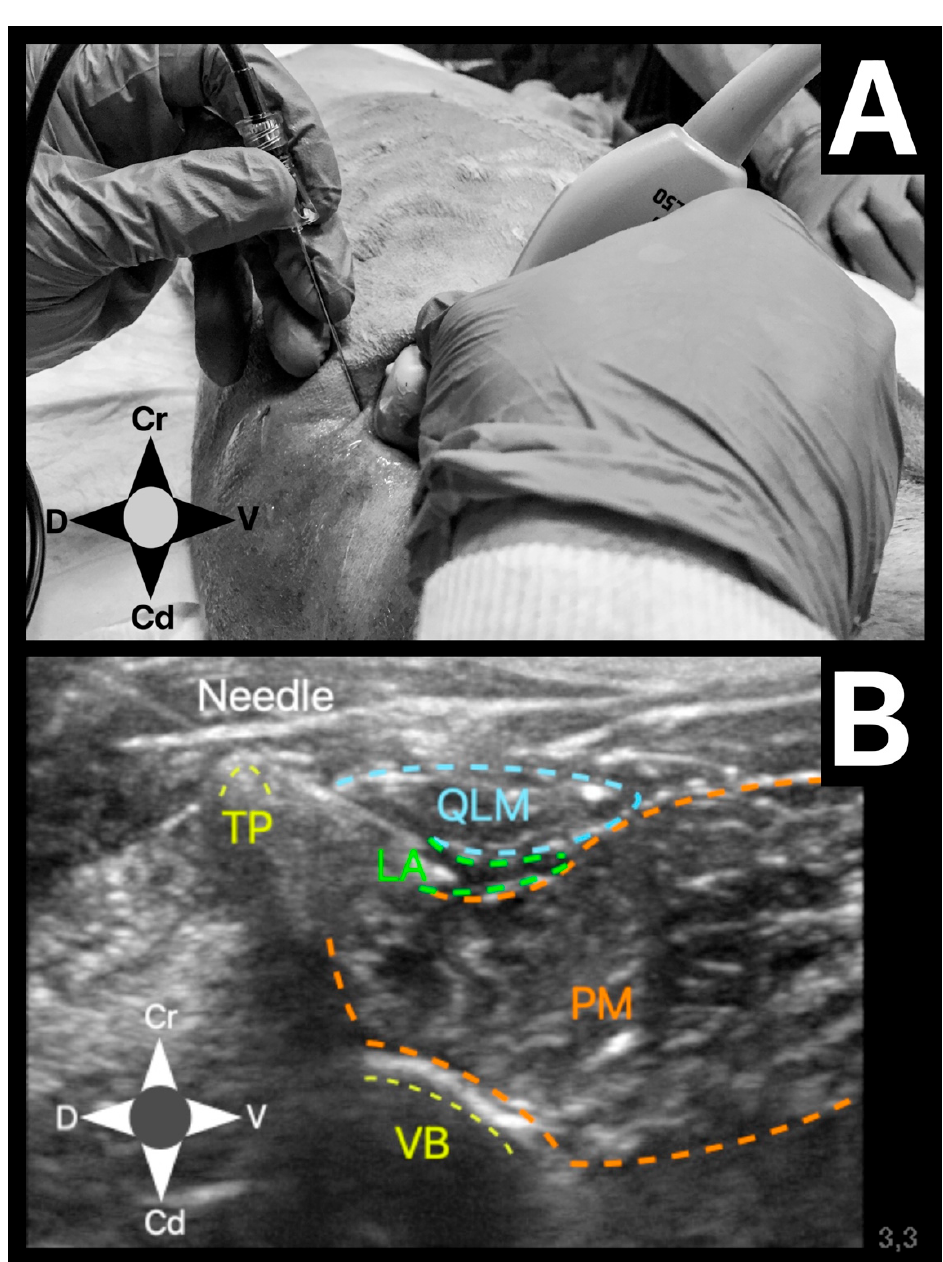
Figure 2. ( A ) Showing the positioning of the ultrasound probe and needle using the in-plane technique. The ultrasound probe was positioned in the lateral aspect of the lumbar muscles, caudal to the last rib, to perform the quadratus lumborum block. Cr, cranial; Cd, caudal; D, dorsal; V, ventral. ( B ) Ultrasound image showing the landmarks of the QLB. TP (yellow), transverse process; VB (yellow), vertebral body; QLM (blue), quadratus lumborum muscle; PM (orange), psoas muscle; LA (green), local anaesthetic between quadratus lumborum and psoas muscle.